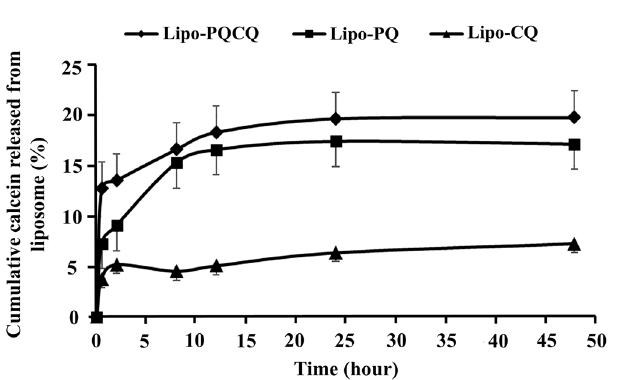
Figure 6. Profiles of calcein release from primaquine-loaded liposomes (Lipo-PQ), chloroquine-loaded liposomes (Lipo-CQ), and liposomes loaded with both primaquine and chloroquine (Lipo-PQCQ) in phosphate-buffered saline (pH 7.4) at 37